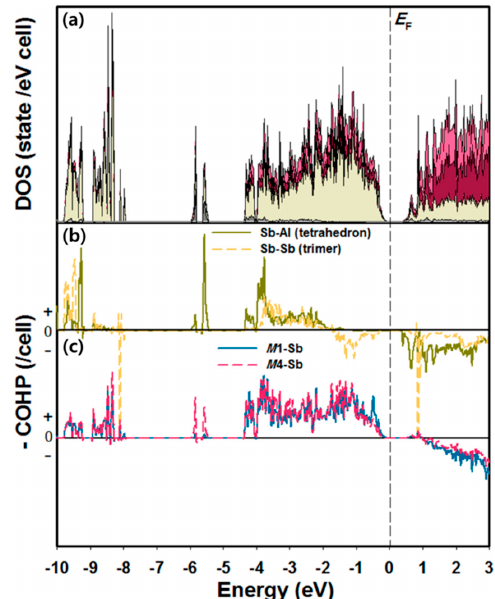
Figure 4. Density of states (DOS) and crystal orbital Hamilton population (COHP) curves for Yb 8 Ca 6 AlSb 11 . ( a ) Total DOS (the most outline), Yb (red region), Ca (pink region), Al (gray region) and Sb (ivory region). COHP curves represent; ( b ) the averaged Sb-Al interactions in the (AlSb 4 ) 9 − and the averaged Sb-Sb interactions in the (Sb 3 ) 7 − ; as well as ( c ) the M 1-Sb and the M 4-Sb interactions of two different ( M Sb 6 ) octahedra environments. E F (dashed vertical line) is the energy reference (0 eV).